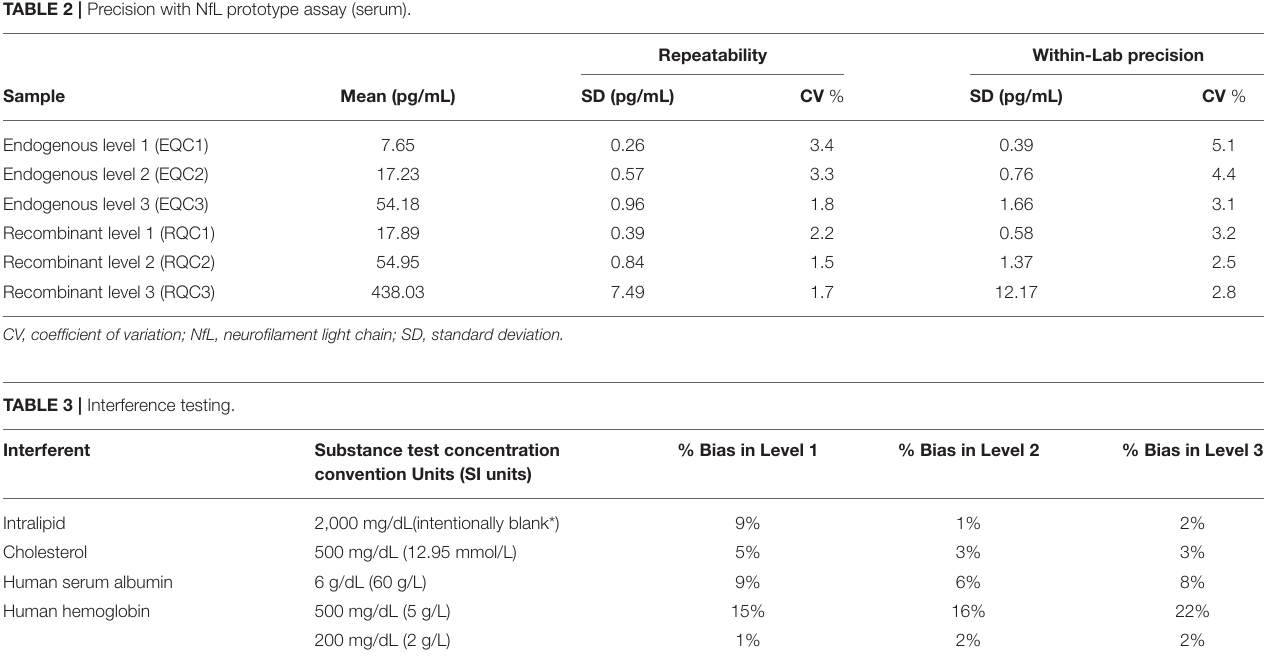
TABLE 2 | Precision with NfL prototype assay (serum).